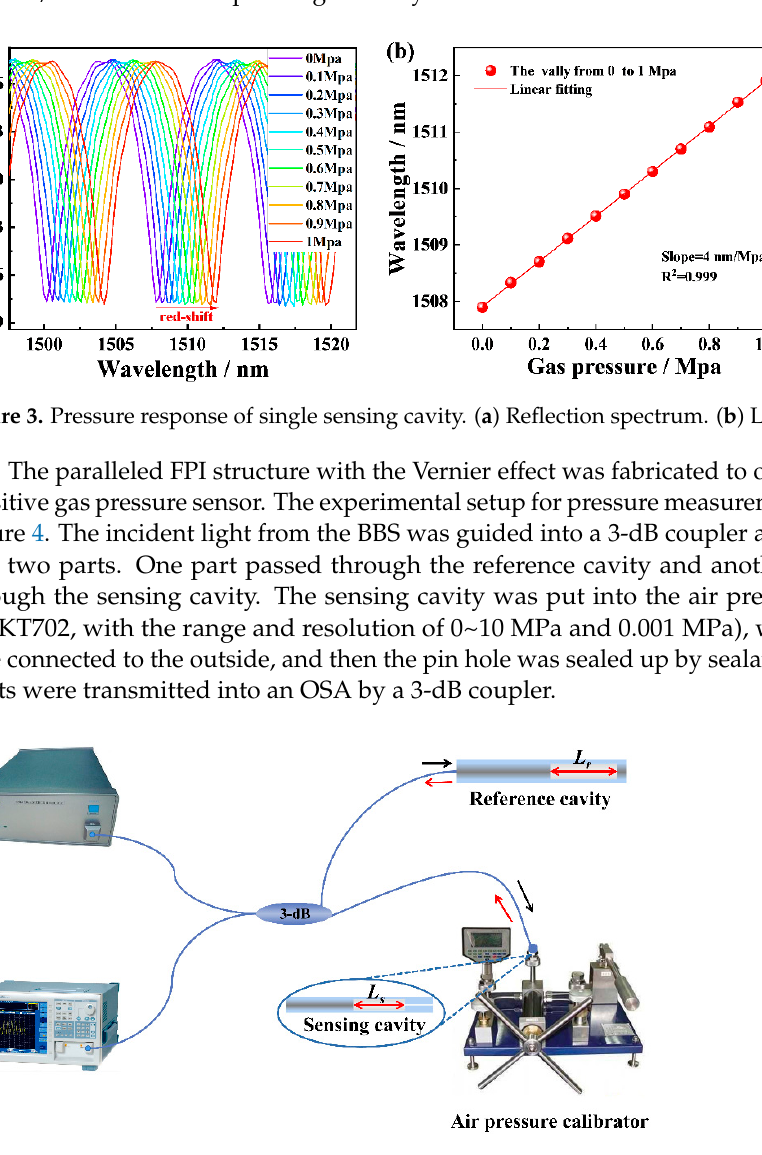
Figure 4. Experimental system for paralleled FPI sensor.